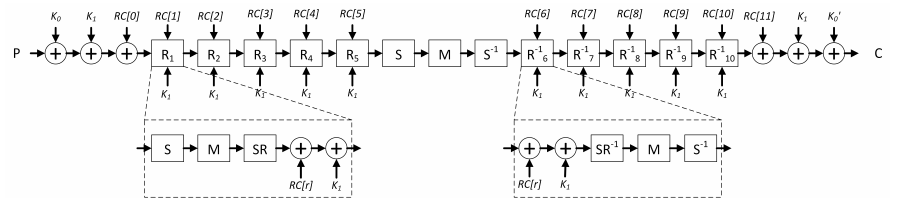
Figure 1. Unrolled architecture of